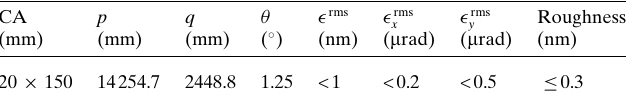
Table 1 Specifications of the elliptical-cylindrical